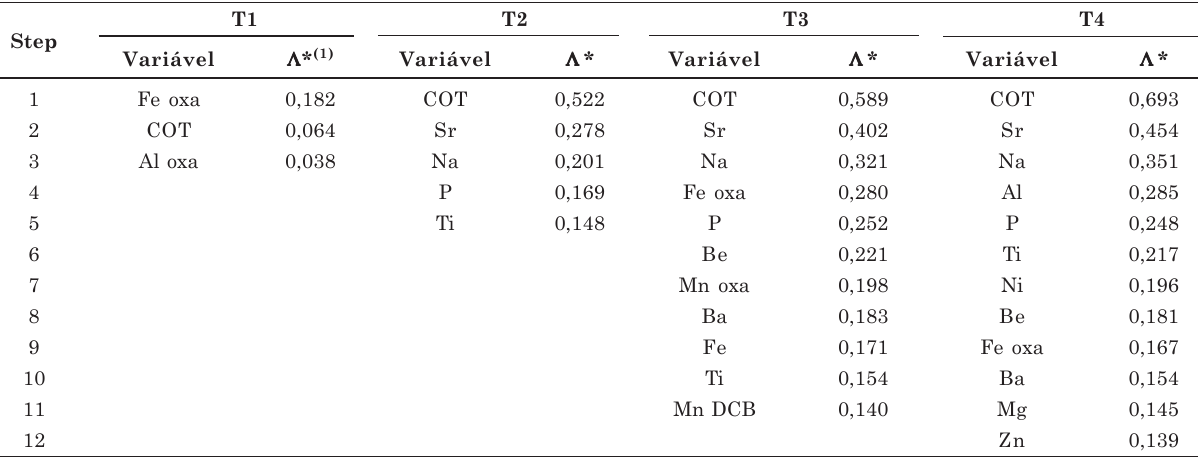
Quadro 5. Resultado da análise da função discriminante, com acréscimo gradual de cada variável, e os valores correspondentes da minimização do Wilk’s Lambda ( Λ